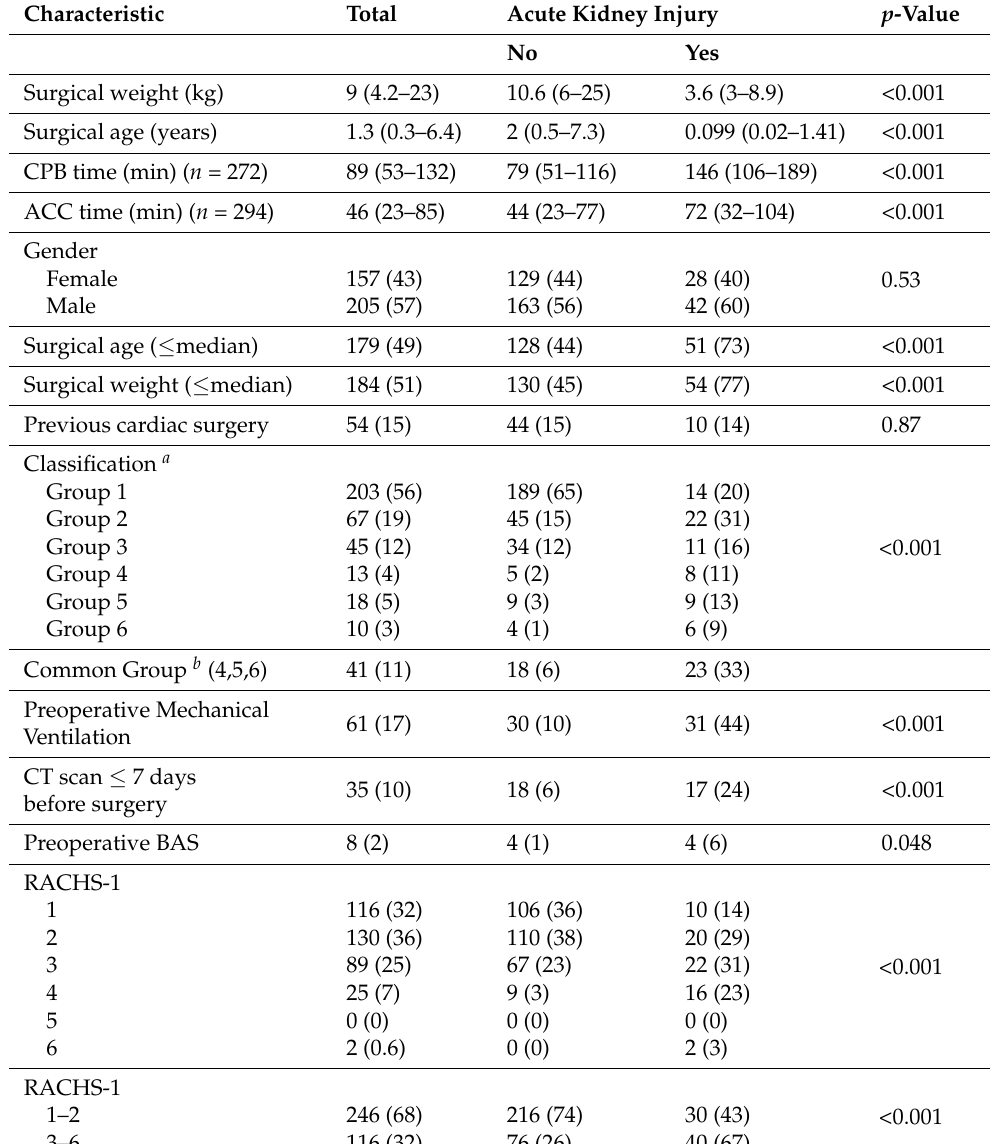
Table 1. Characteristics and outcomes of the patient cohort ( n =